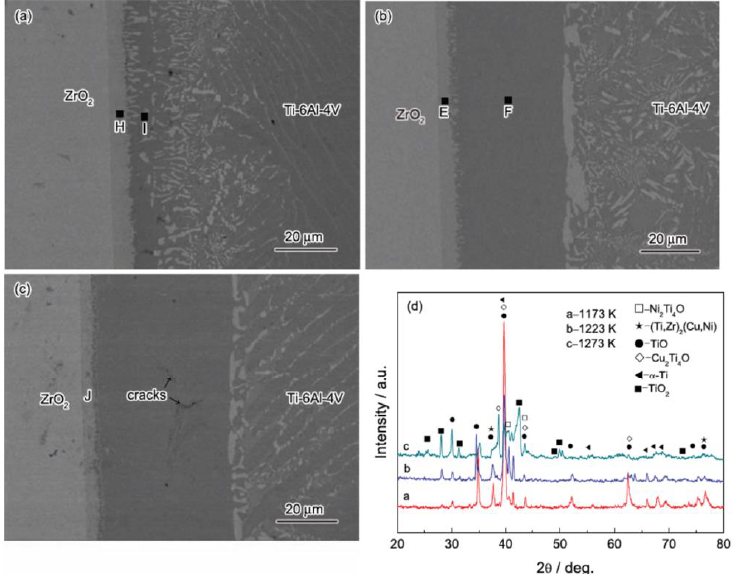
Figure 9. SEM images of the Ti6Al4V/ZrO 2 interfaces in the joints brazed at ( a ) 900 ◦ C, ( b ) 950 ◦ C, ( c ) 1000 ◦ C and ( d ) X-ray diffraction (XRD) patterns for the interfacial reaction products produced at different brazing temperatures, reproduced from Reference [31] with permission of Elsevier, 2011.